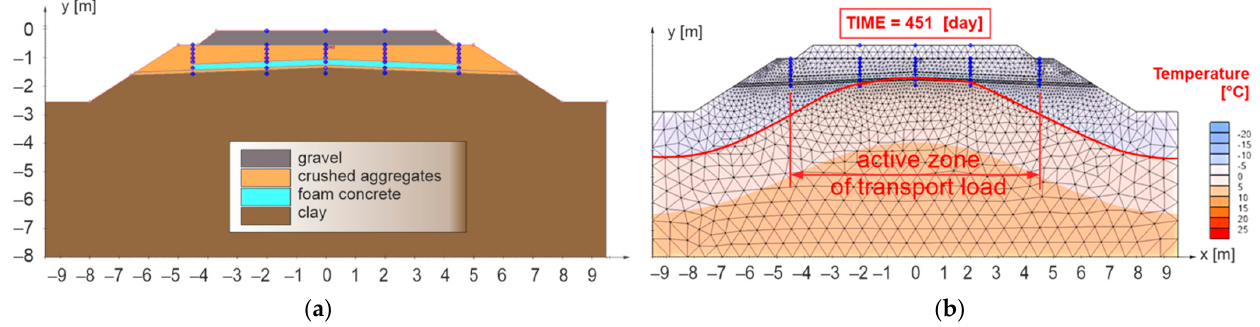
Figure 11. Numerical model No. 1—double-track railway with horizontal sub-ballast upper surface and with built-in composite layer of FC to the width of the active zone of traffic load for the applied climate conditions I F = 1400 °C, day and θ m = 2 °C ( a ), day of reaching the highest freezing depth of structural layers of numerical model ( b ).